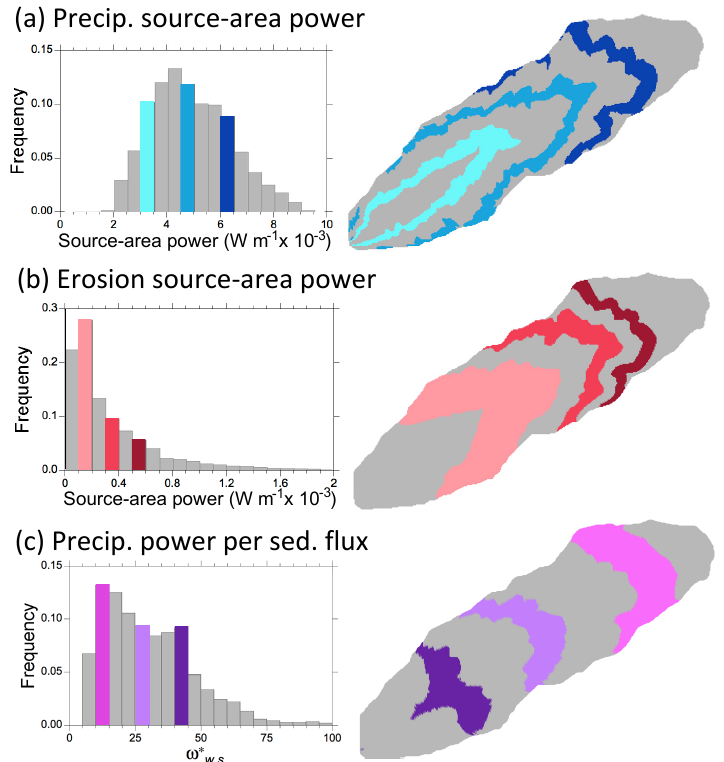
Figure 6. Spatial distribution of source-area power for water and sediment. Histograms (left) of source-area power calculated using Eq. (3) for the Inyo Creek catchment for water delivered by precipitation (a) and sediment produced by erosion (b) . Panel (c) shows dimensionless ratio of source-area water power to sediment production rate (Eq. 4); colors highlight bins of relatively low, medium, and high values. Maps (right) show spatial distribution of highlighted values. Note the sharp increase in water power per sediment flux from upper to lower parts of the